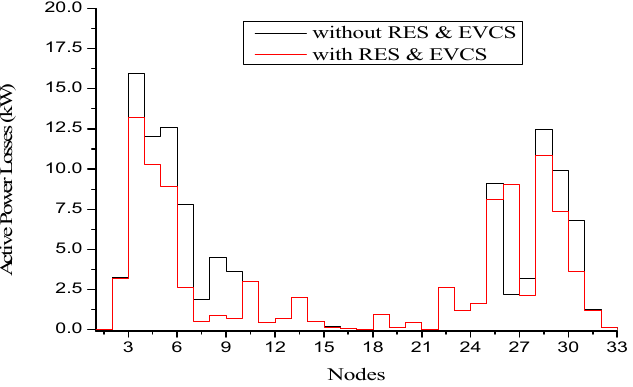
Figure 11. Active power losses with and without the integration of RES and